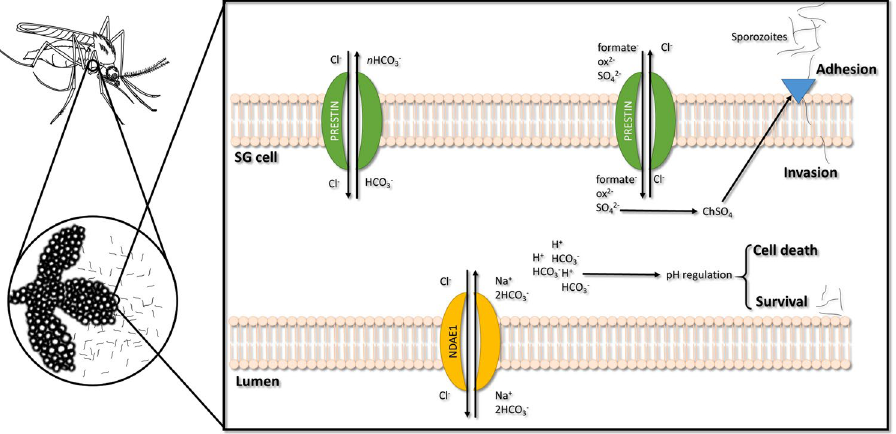
Figure 7. Proposed model for prestinA and NDAE1 physiological functions and impact on SG cell and Plasmodium berghei infection. PrestinA is expressed at apical membrane of cells, mediates the uptake of sulfate and excretes bicarbonate which is produced by carbonic anhydrase or supplied by NDAE1. Disruption of prestinA alters the biosynthesis of chondroitin sulfate which interferes with Plasmodium adhesion. A reduction of both prestinA and NDAE1 changes cell pH, affecting Plasmodium and mosquito